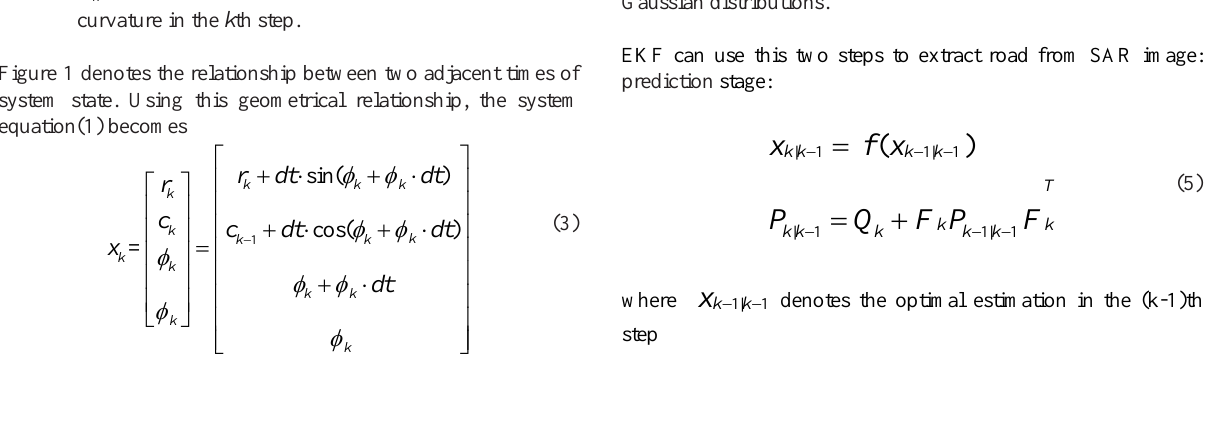
Figure 1. model of road extracting × denotes the prediction, hollow circle denote the measurement, solid circle denotes the optimal estimate 2.2 EKF and PF EKF and PF based on Bayesian recursive problem contain two steps(prediction and update). The specific procedure is as follows: obtain prior probability density function by prediction stage, and through prior probability density function and the new measurement(update stage), we can obtain the posterior probability density function. EKF When the nonlinearity of the system and/or measurement equations is not severe, (1) and (2) can be linearized around the state prediction estimate(Movaghati, S, 2010). We assume that w and v have both system and measurement noise processes k k Gaussian